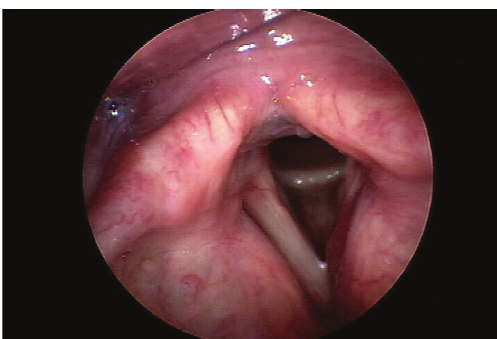
Figure 1: Videostroboscopic image revealing an erythematous, submucosal mass arising from and e ff acing the left ventricle, representing extension of the mass into the laryngeal introitus.